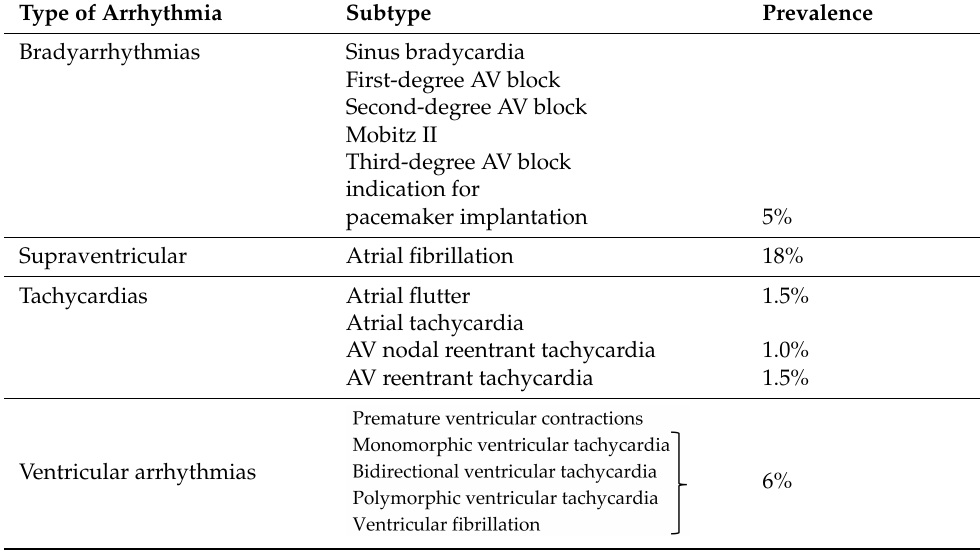
Table 3. Observed arrhythmias in patients with